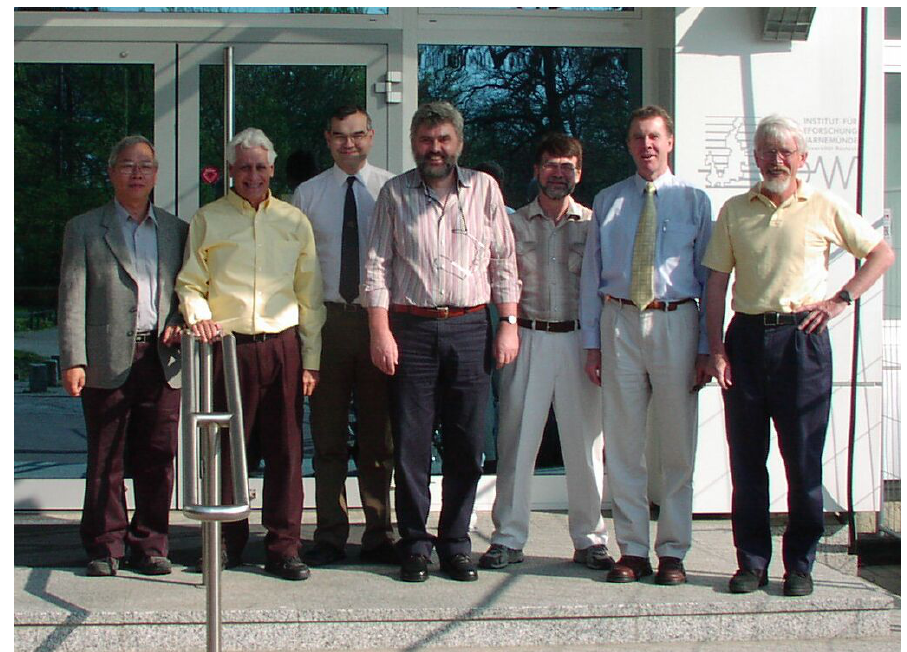
Figure B1. Participants from left to right: Chen-Tung Arthur Chen (Taiwan), Frank J. Millero (USA), Brian A. King (UK), Rainer Feistel (Germany), Daniel G. Wright (Canada), Trevor J. McDougall (Australia), Giles M. Marion (USA). Photo taken in front of the Baltic Sea Research Institute,